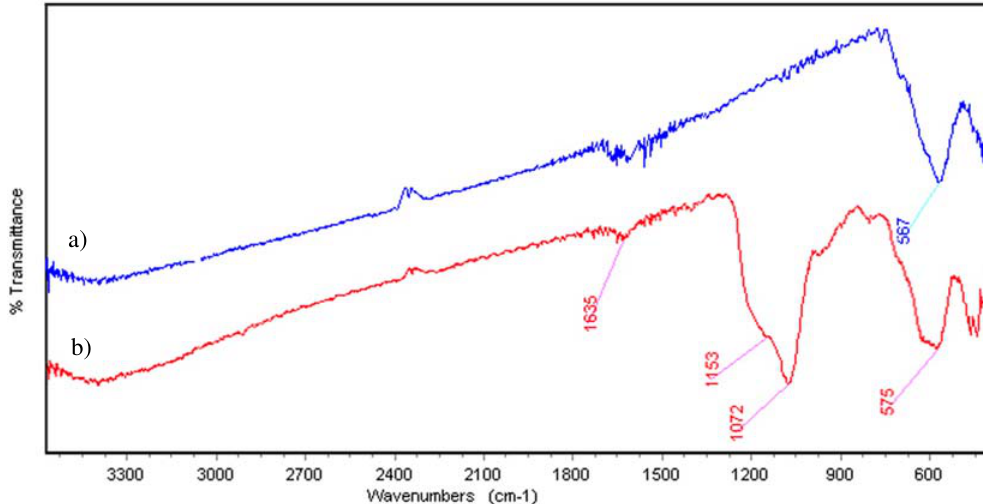
@ SiO O (b) nanoparticles 3 4 2